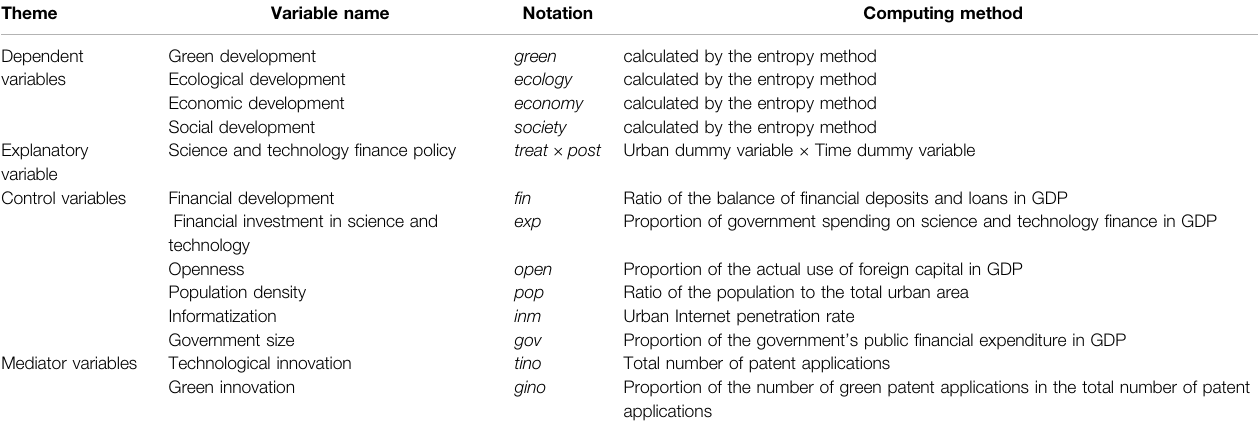
TABLE 2 | Description of variables.